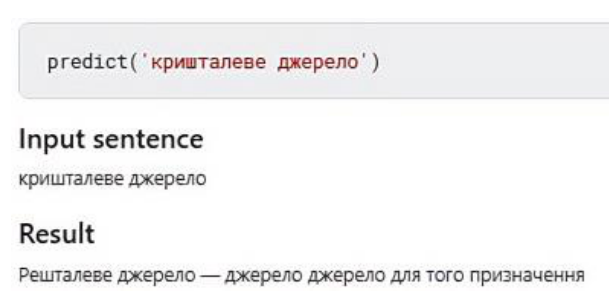
Figure 10. Sentence changing by neural network.